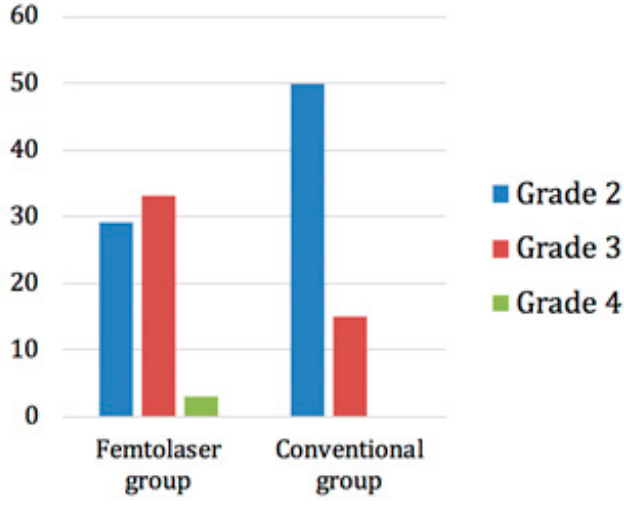
Figure 5. Distribution of cataract grades in the two groups .